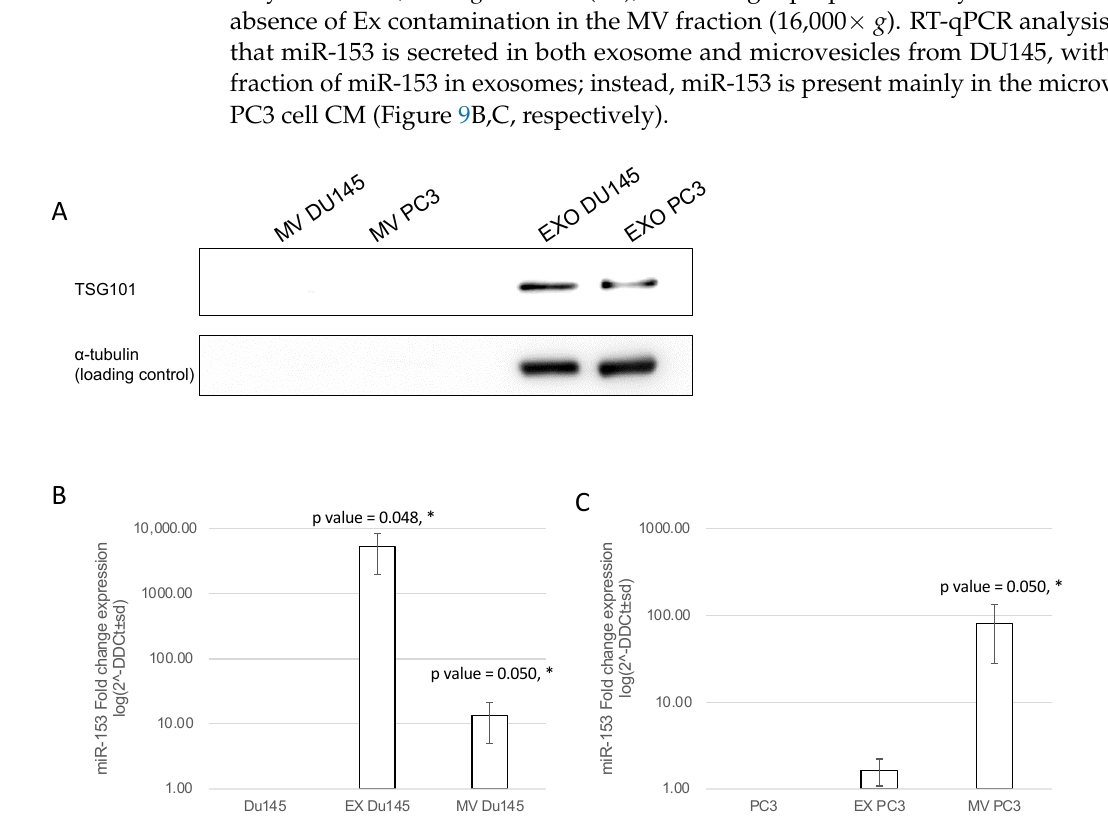
Figure 9. miR-153 is secreted by microvesicles (MV) and exosomes (Ex). ( A ) DU145 and PC3 cell homogenates together with microvesicles and exosome fractions obtained from DU145 and PC3 conditioned media were analyzed by Western blot for the exosome marker TSG101. Then, 30 µ g of cell homogenate and the corresponding MV and Ex isolated from 1.5 mg of cell proteins were loaded. TSG101 protein was found in cells and in the exosome fraction. MV and Ex isolated from conditional medium of PC3 ( B ) and DU145 ( C ) cells showed a significant increase in miR-153 expression, com- pared to the content of intracellular miR-153 of DU145 or PC3 cells, used as reference. Log scale of fold change expression is represented. Average of two independent experiments performed in duplicate ( t test, p value ≤ 0.05,